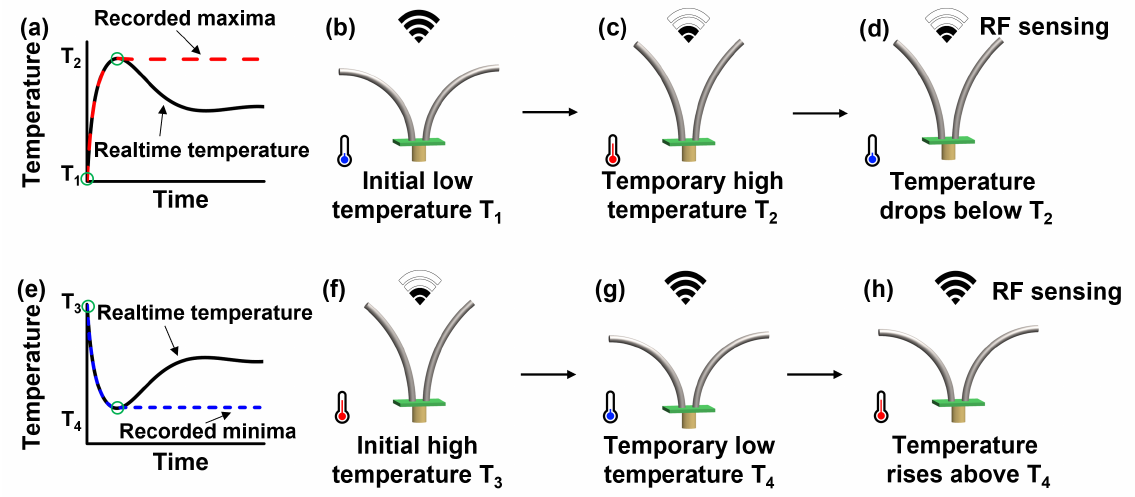
Figure 3. ( a ) SMA antenna records the maximum history temperature. ( b ) Antenna presents a large opening angle at an initial low temperature. ( c ) Antenna presents a small opening angle at the highest temperature. ( d ) Antenna keeps the small opening angle when the temperature drops. ( e ) SMA antenna records the minimal history temperature. ( f ) Antenna present a small opening angle at an initial high temperature. ( g ) Antenna presents a large opening angle at the lowest temperature. ( h ) Antenna keeps the large opening angle when the temperature